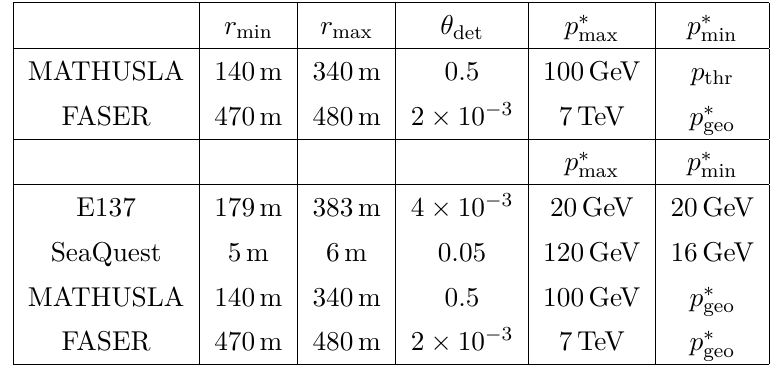
Table 2 . A summary of features of visible decay searches: MATHUSLA, FASER, E137, and SeaQuest. The top block corresponds to the dark nucleon searches, while the bottom block corre- sponds to the dark pion searches. The subscripts of momenta, max and min , correspond to (cid:15) and (cid:15) , respectively, and do not necessarily coincide with the maximum or minimum min